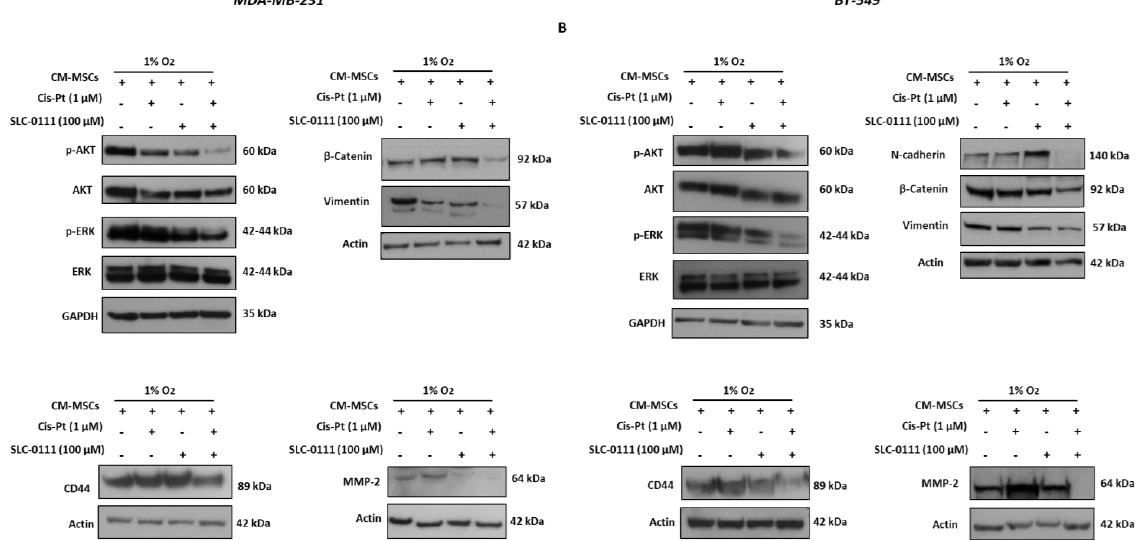
Figure 6. SLC-0111 increases Cis-Pt effect on CM-MSC-induced signaling pathways in TNBC cells. MDA-MB-231 ( A ) and BT-549 ( B ) cells grown for 72 h in hypoxic conditions (1% O 2 ) and in presence of the CM-MSCs were treated with SLC-0111 (100 µM) and Cis-Pt (1 µM), alone or in com- bination. Expression levels of p-ERK/ERK, p-AKT/AKT, N- cadherin, β -Catenin, vimentin, CD44 and MMP-2 were analyzed. Equal loading was confirmed by immunoblot with anti-actin and anti- GADPH antibodies. Representative images are